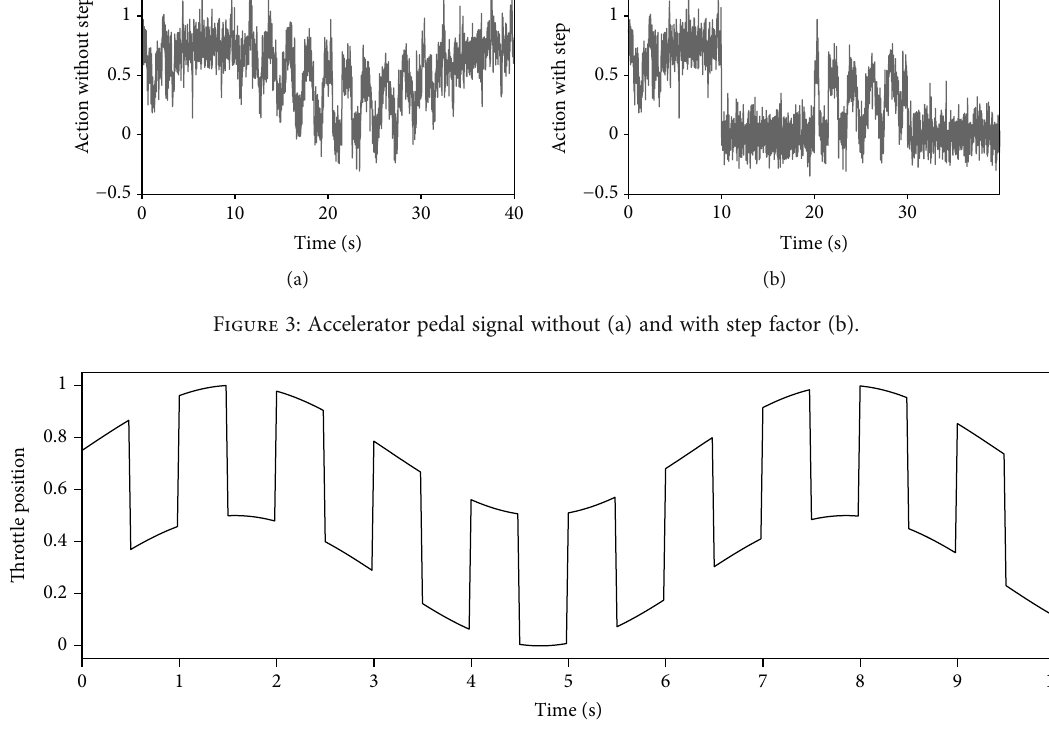
Figure 4: Driver pedal position